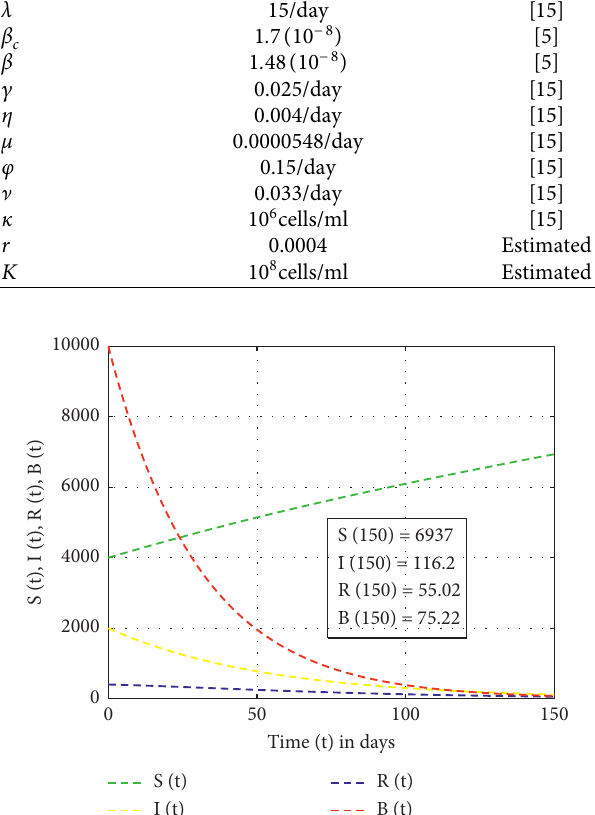
Figure 2: Simulation of the SIR-B model with u � 0 , and u � 0. u 2 3